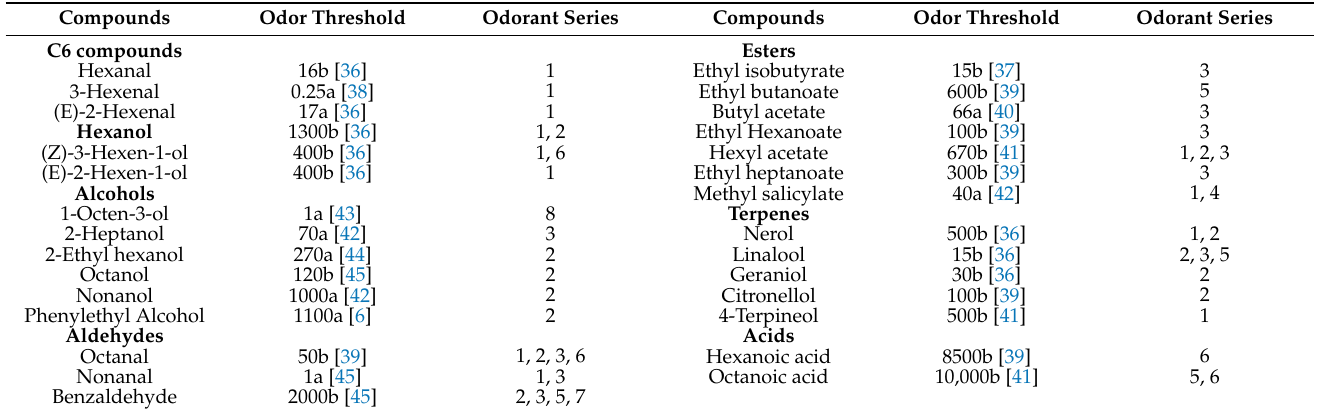
Table 2. Odor threshold ( µ g/L) and odorant series of partial aroma compounds. Odorant series: 1, herbaceous; 2, floral; 3, fruity; 4, spicy; 5, sweet; 6, fatty; 7, roasty; 8, earthy. a: determined in water solution. b: determined in ethanol-water